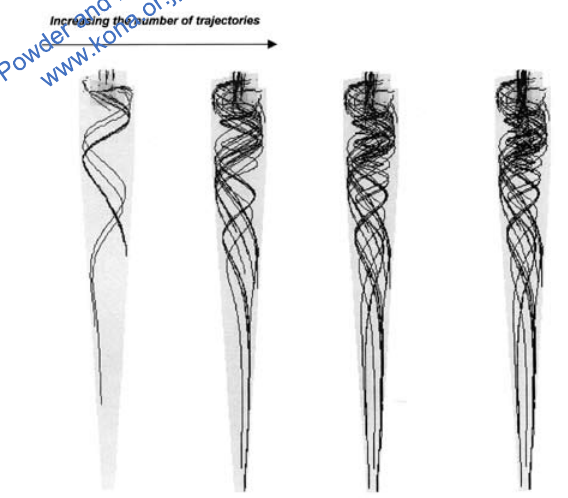
Fig.2 Simulation results obtained from the developed finite element soft- ware. Trajectories of mass less particles released from the hydro- cyclone inlet (Nowakowski and Dyakowski,